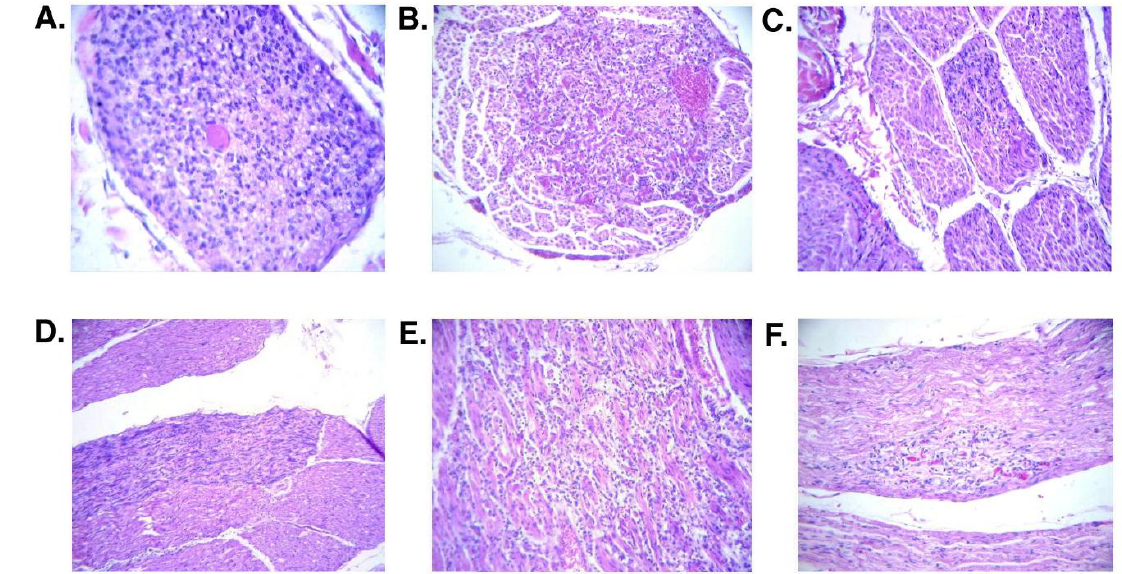
Figure 4. Developmentally arrested structural elements (DASEs), incidentally discovered in grossly normal-appearing nerve root tissue of VHL patients by histologic analysis of random spinal cord sections obtained at autopsy (from Vortmeyer et al., Ann. Neurol. 2004; 55:721-728). All depicted DASEs were present intradurally in different nerve roots. All lesions reveal circumscribed accumulations of persistent embryonal VHL-deficient hemangioblast progenitor cells (see references 24 and 98). A, cross-section of a nerve root, filled with embryonal cells; B , The central portion of the root shows an accumulation of embryonal cells which is sharply demarcated from surrounding normal root tissue; C, A longitudinal nerve root section reveals frequently observed longitudinal extension of DASE’s along fiber tracts; D, intraradicular DASE with embryonal cells, diffusely scattered around neurites; E, DASE, selectively involving a central nerve root fascicle; F, circumscribed DASE in nerve root; focal clear cell phenotype and early multifocal vascular perfusion may indicate early progression into hemangioblastoma.